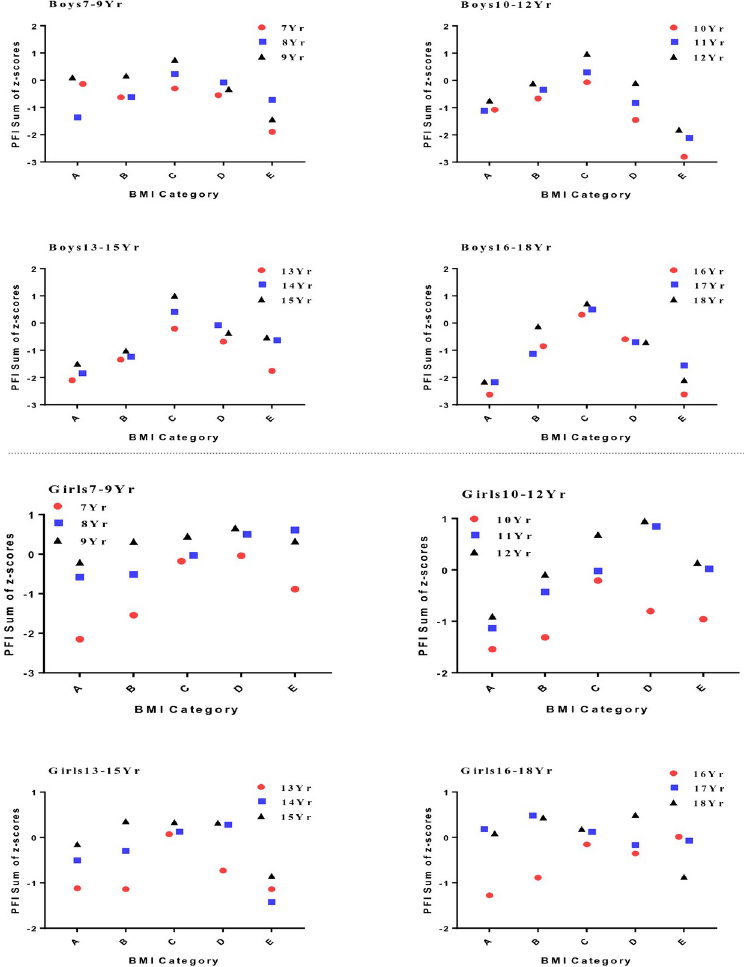
Fig 1. Trends in physical fitness index and body mass index for participating children and adolescents by age group. A: BMI < 5th Percentile; B: 5th � BMI < 15th Percentile; C: 15th � BMI < 85th Percentile; D: 85th � BMI < 95th Percentile; and E: BMI � 95th